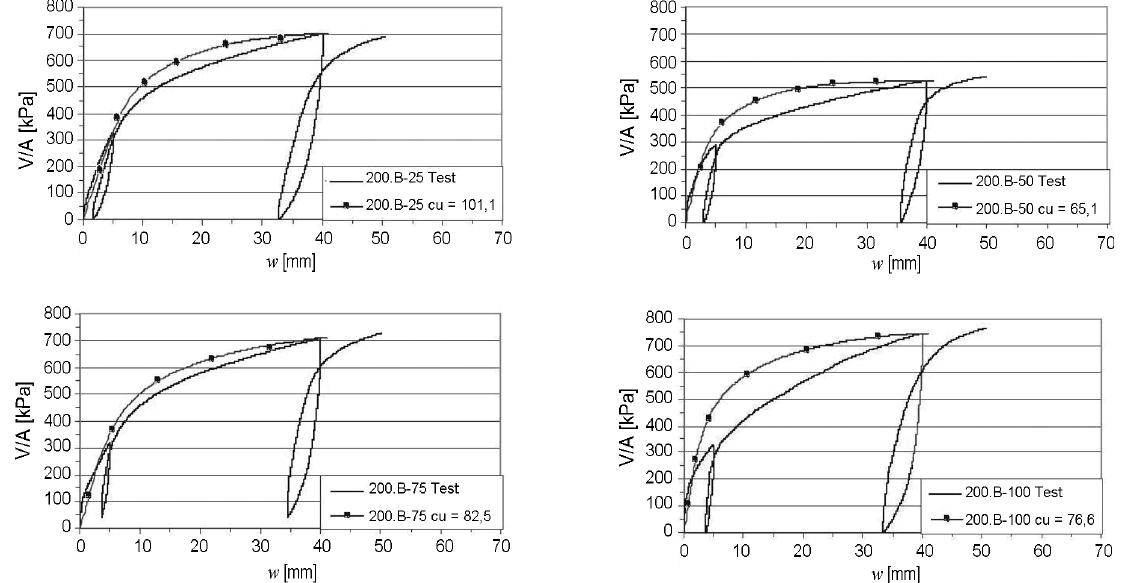
Fig. 15. Best fit curve for load-displacement data from field tests for vertical loading of 20-cm bucket